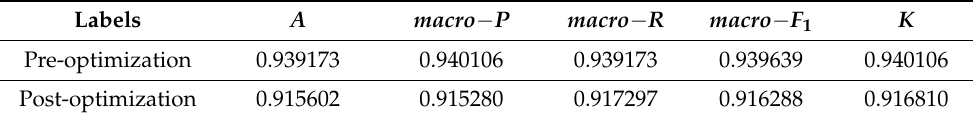
Table 7. Statistical table of numerical indicators of optimization order. Labels A macro − P macro − R macro − F 1 K Pre-optimization 0.939173 0.940106 0.939173 0.939639 0.940106 Post-optimization 0.915602 0.915280 0.917297 0.916288